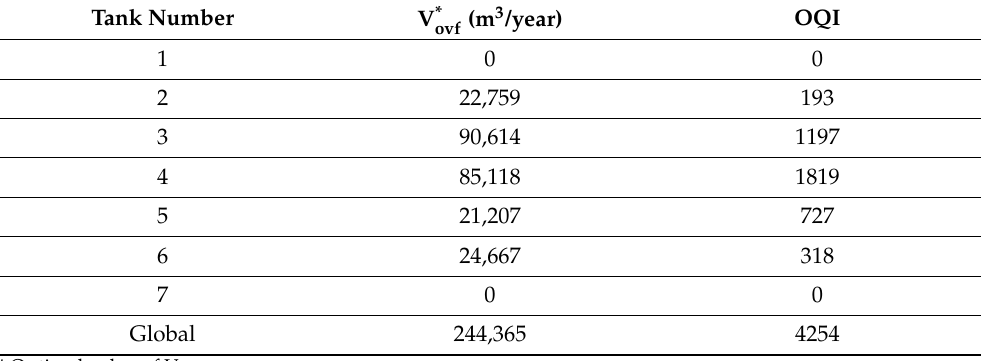
Table 11. Simulation results when the volume of overflow is minimized (strategy #3).